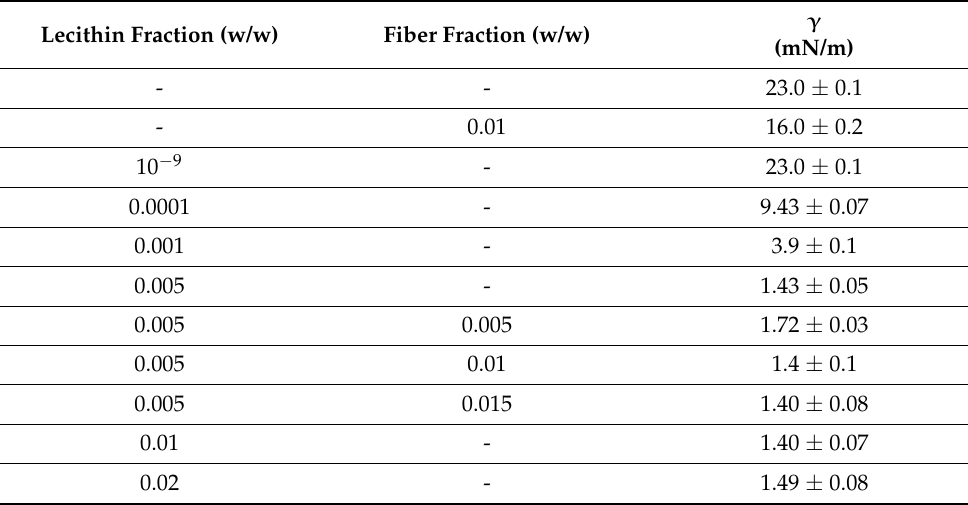
Table 4. Samples investigated by interfacial test and interfacial tension values ( γ ). Lecithin was added to oil phase; fiber to water